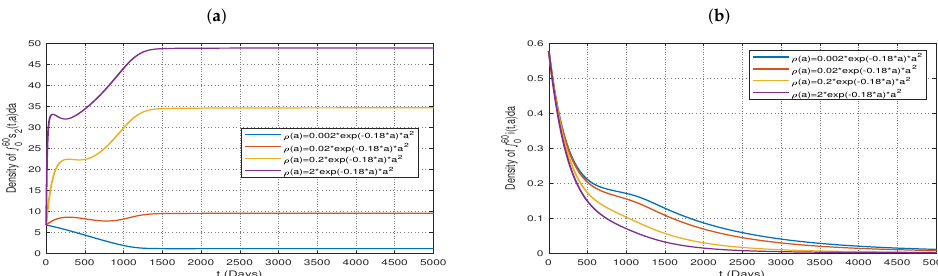
Figure 8. The influence of education rate ρ ( a ) on the distribution of HIV/AIDS, that is the effects of the protection-aware for susceptible and asymptomatic infected individuals: ( a ) the effect of ρ ( a ) (cid:82) 60 s 2 ( t , a ) d a ; ( b ) the effect of ρ ( a ) for the cumulative distribution for the cumulative distribution 0 (cid:82) 60 i ( t , a ) d a 0